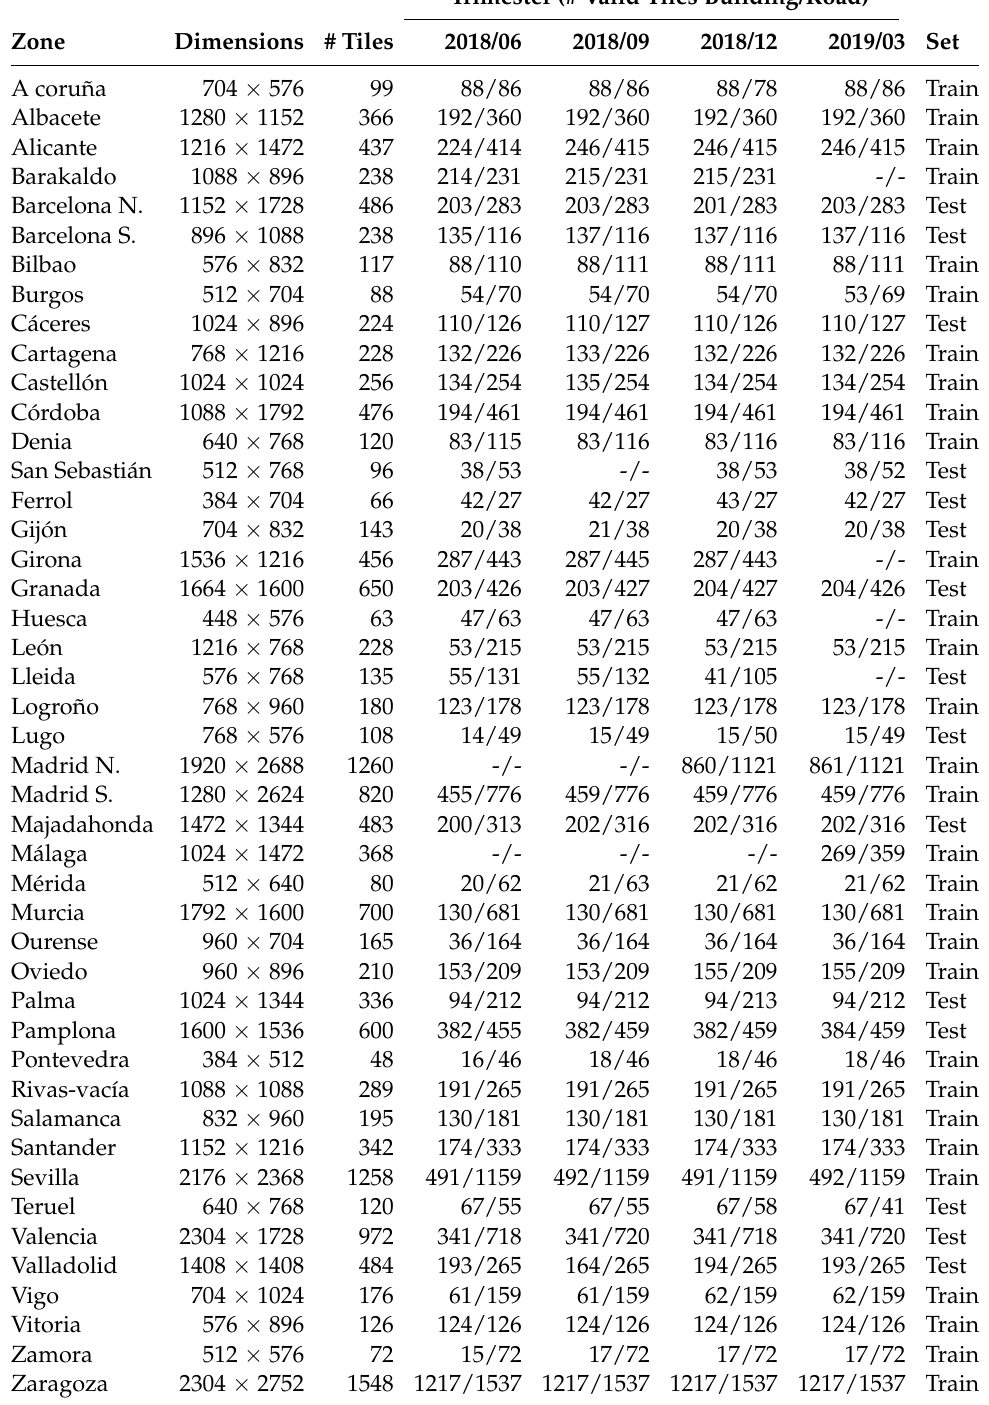
Table 1. Summary of the data-set. Overall, the training set comprises 31 zones (70.45%) whereas the testing set consists of 13 zones (29.55%). Discarded trimesters are marked with a